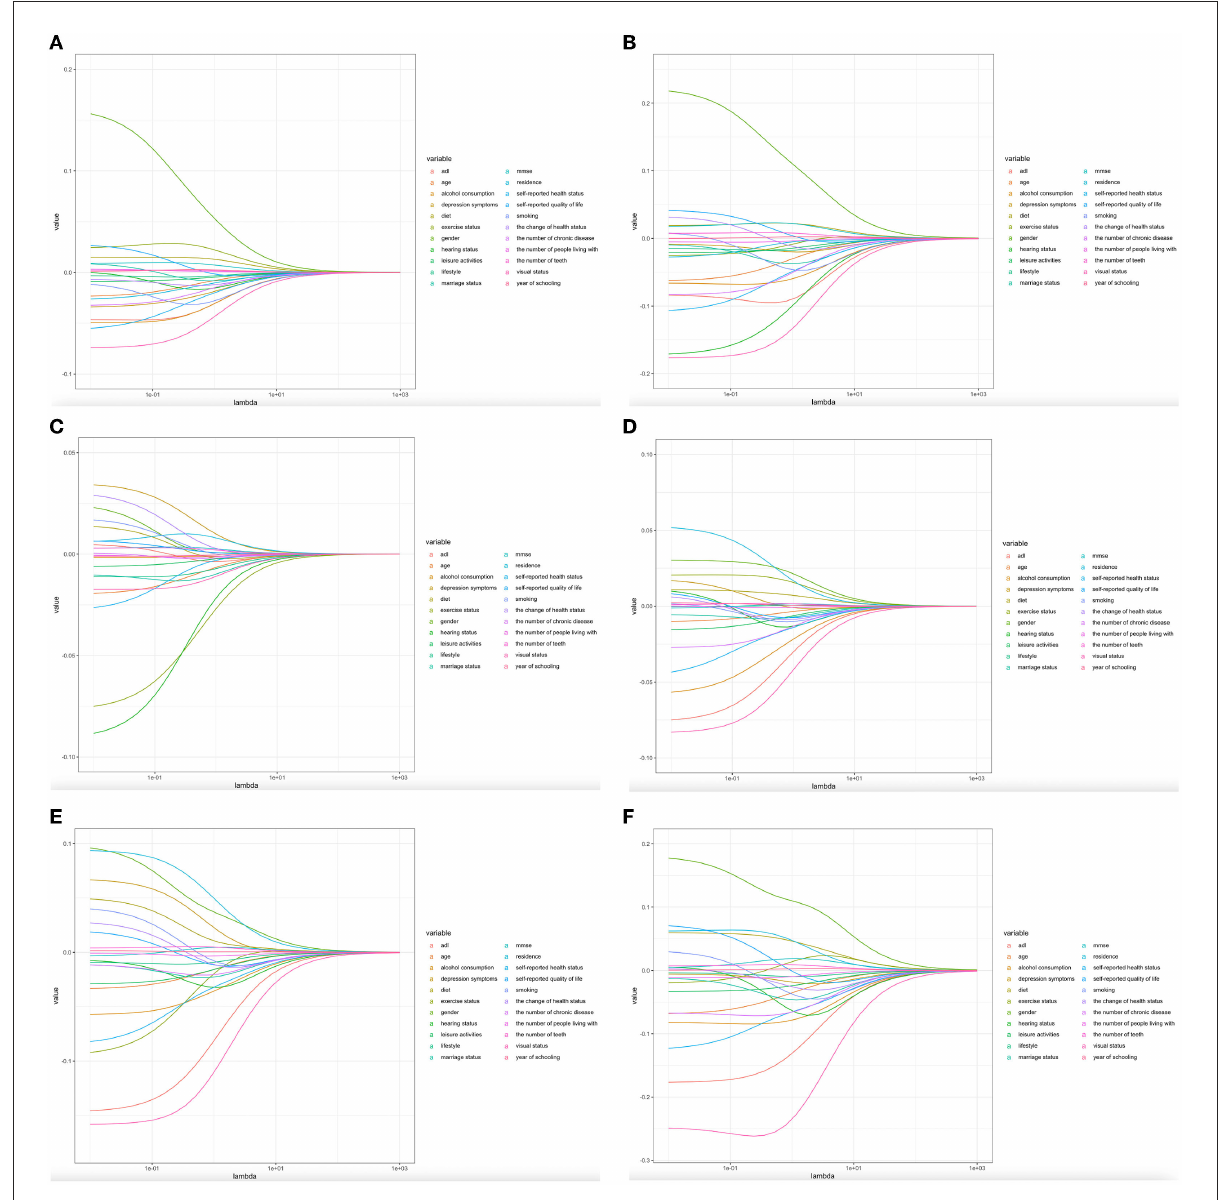
FIGURE3 Predictors’ selection using Lasso regression. (A–F) Lasso coefficient profiles of all the clinical